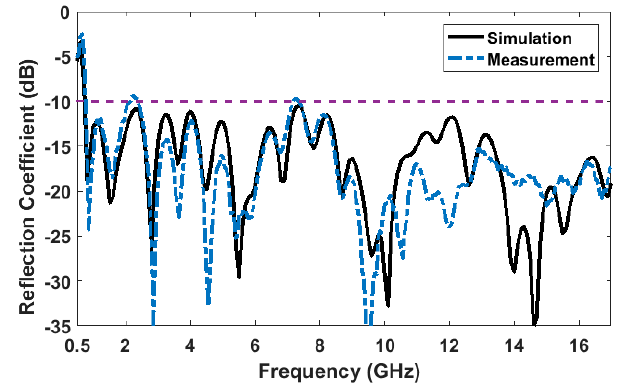
Figure 10. Reflection coefficient of the proposed antenna.